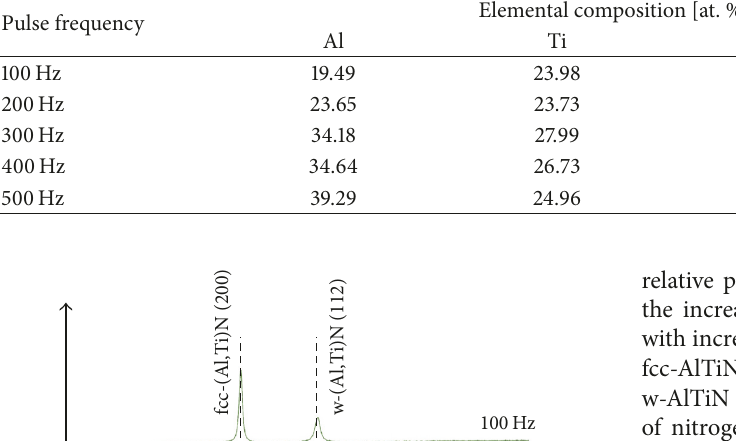
Table 2: Elemental composition and stoichiometry of the (Al,Ti)N coatings at different pulse frequencies. Pulse frequency